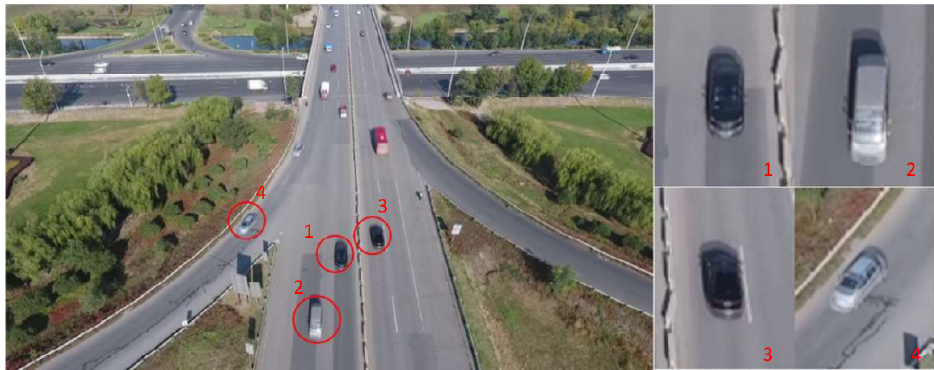
Figure 14. The overlaid image of the warped image and the reference image. The weights of the warped image and the reference image are each 0.5. The left image is the overlaid image. We circle four vehicles as examples to show the results of warping. The right four images are large vision of the circle vehicles which are represented in a reference coordinate system.